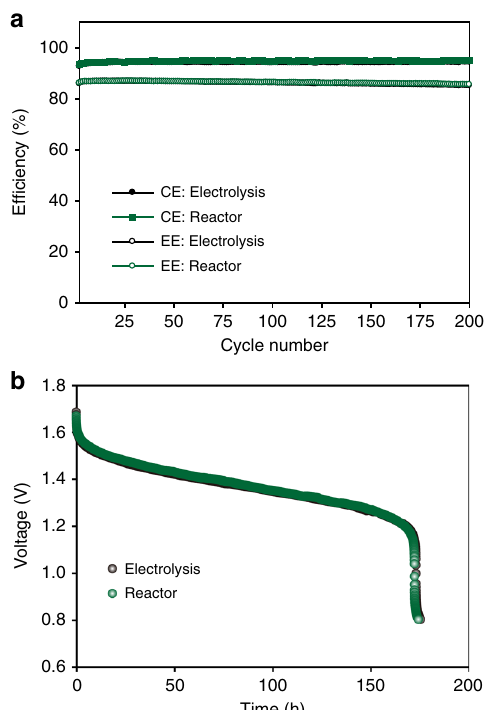
Fig. 7 Electrochemical stability of the reactor electrolyte. a Cell performances of the electrolytes prepared by the catalyst reactor and electrolysis under a wider voltage window (0.7 – 1.9 V). b Self-discharge test for the reactor and electrolysis electrolytes after the charge up to 2.4